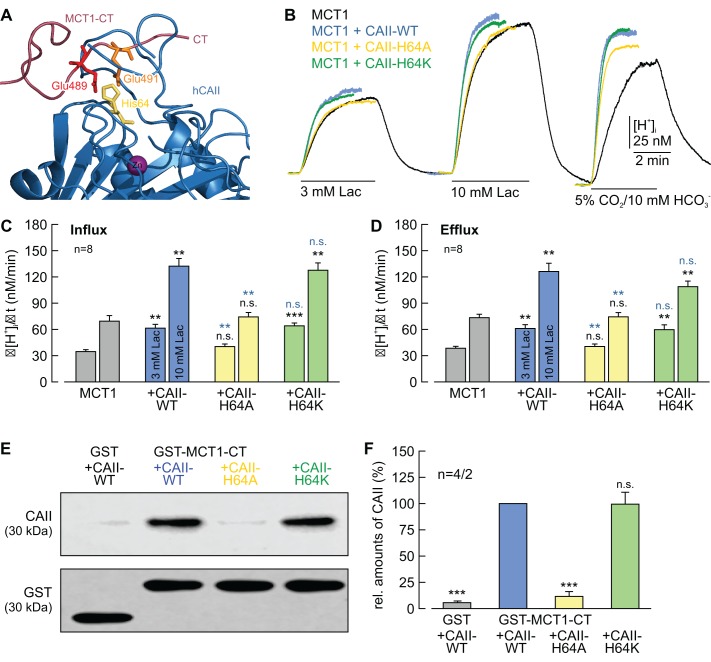
CAII-His64 mediates binding, but no proton transfer, between MCT1 and CAII.(A) Structural model of the binding between the C-terminal tail of MCT1 (purple) and CAII (blue). Binding is mediated by Glu489 (red) and Glu491 (orange) in the MCT1 C-terminal tail and His64 (yellow) in CAII. (B) Original recordings of the change in intracellular H+ concentration in oocytes expressing MCT1 (black trace), MCT1 +CAII-WT (blue trace), MCT1 +CAII-H64A (yellow trace), or MCT1 +CAII-H64K (green trace) during application of 3 and 10 mM of lactate and of 5% CO2 and 10 mM HCO3–. (C, D) Rate of change in intracellular H+ concentration (Δ[H+]/Δt) as induced by the application (C) and removal (D) of 3 or 10 mM lactate to oocytes expressing MCT1 (gray), MCT1 +CAII-WT (blue), MCT1 +CAII-H64A (yellow), or MCT1 +CAII-H64K (green) (mean +SEM). The black significance indicators refer to MCT1, the blue significance indicators refer to MCT1 +CAII-WT. (E) Representative western blots for CAII (upper panel) and GST (lower panel). CAII-WT, CAII-H64A, and CAII-H64K were pulled down with a GST fusion protein of the C-terminal of MCT1 (GST-MCT1-CT). As a negative control, CAII-WT was pulled down with GST alone. (F) Relative intensity of the fluorescent signal for CAII (mean +SEM). The signal intensity of CAII pulled down with GST-MCT1-CT was set to 100%. The significance indicators refer to the original values of CAII-WT. ***p≤0.001, n.s. no significance, Student’s t-test.10.7554/eLife.35176.026Figure 8—source data 1.Original dataset for Figure 8.